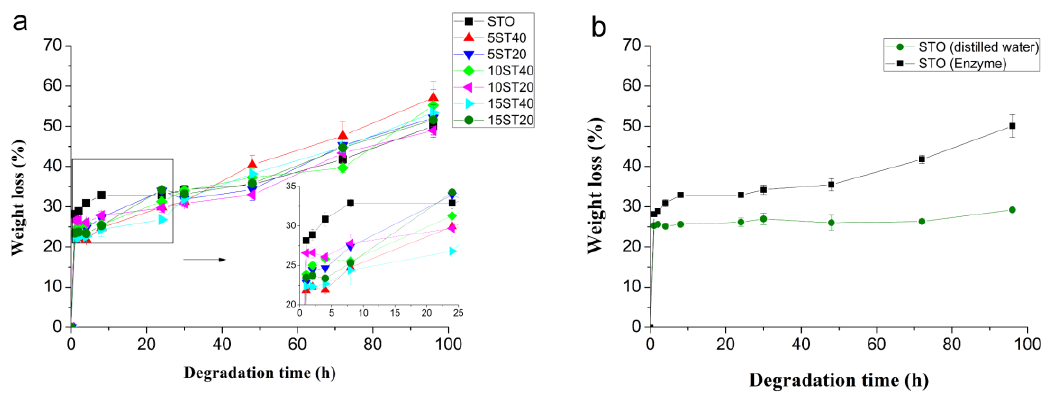
Figure 5. Figure 5. ( a ) Hydrolytic profiles of composite films based on thermoplastic starch as polymer matrix and CNF as reinforcement. ( b ) Comparison between STO behavior with and without enzymatic agents (distilled